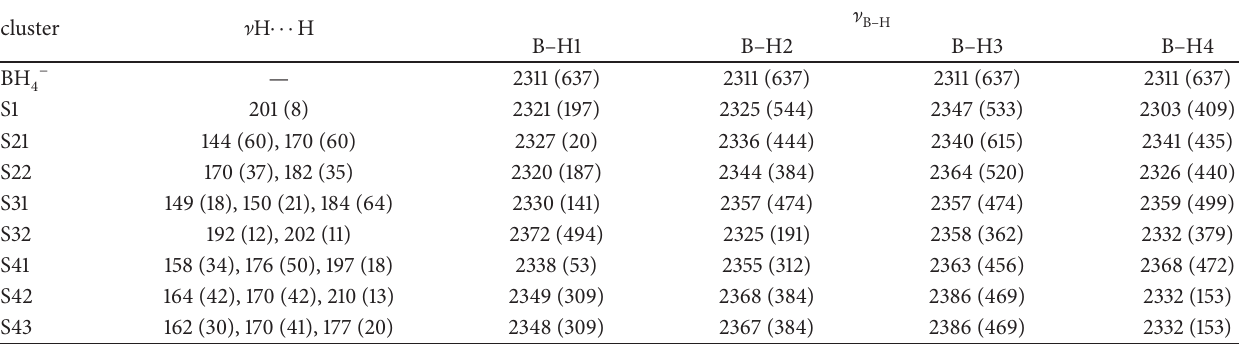
Table 4: Unscaled vibration frequencies (cm − 1 ) with corresponding intensities (values given in parenthesis, kmmol − 1 ) of HB clusters calculated at MP2/6-311++G(d,p) level.